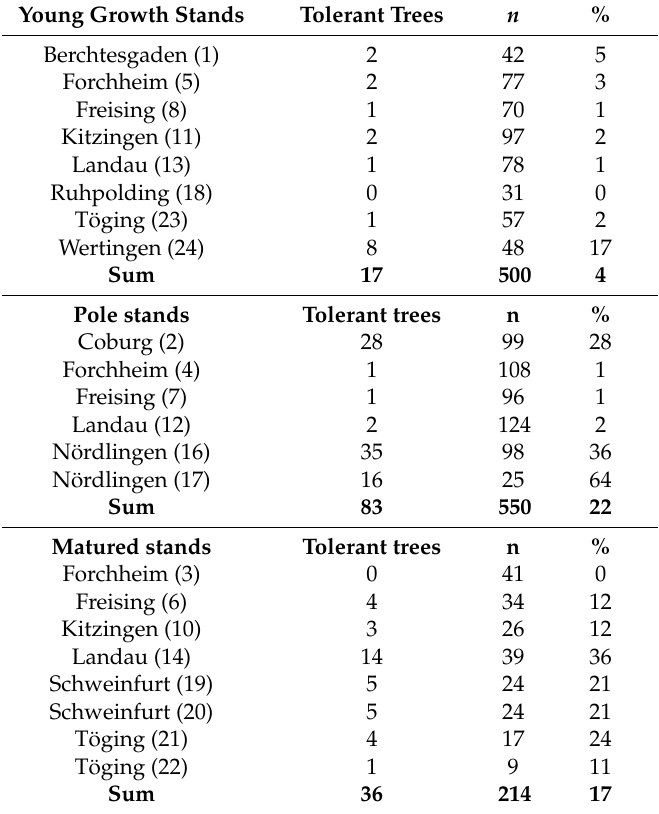
Table 4. Age-dependent number of potentially resistant/tolerant trees that belong to the vitality classes 0–1 from 2010 to 2014. The percentage is calculated with the amount of trees found in 2014. Young Growth